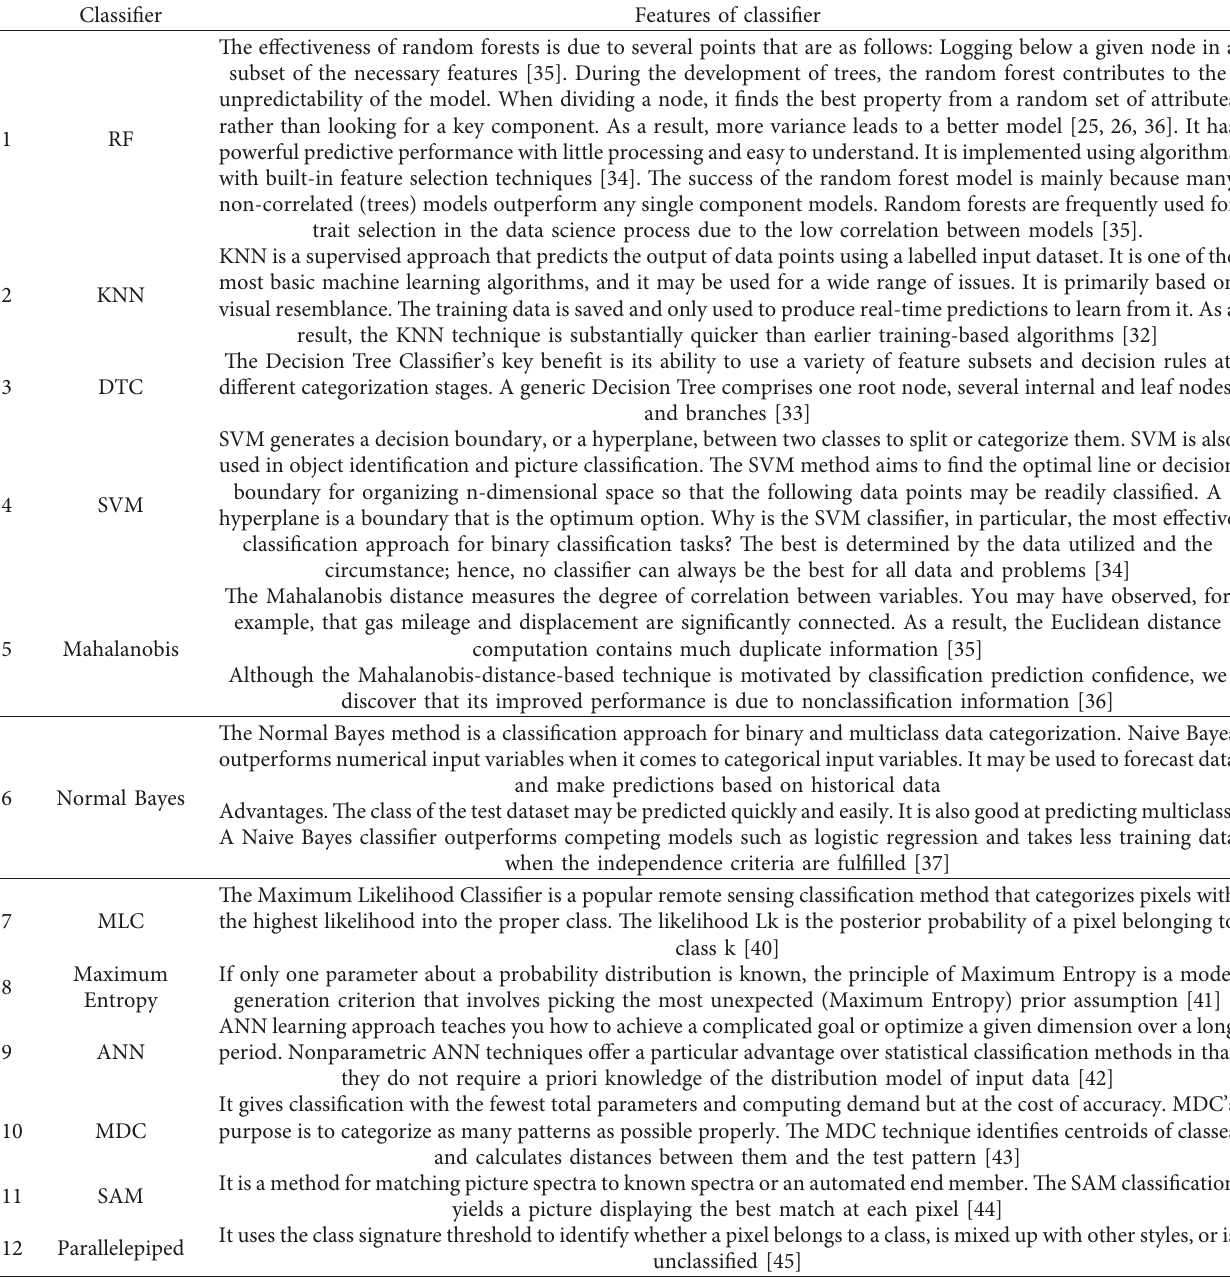
Table 2: Limitations, stability, and weaknesses of twelve classifiers implemented in this study [28]. Classifier Features of